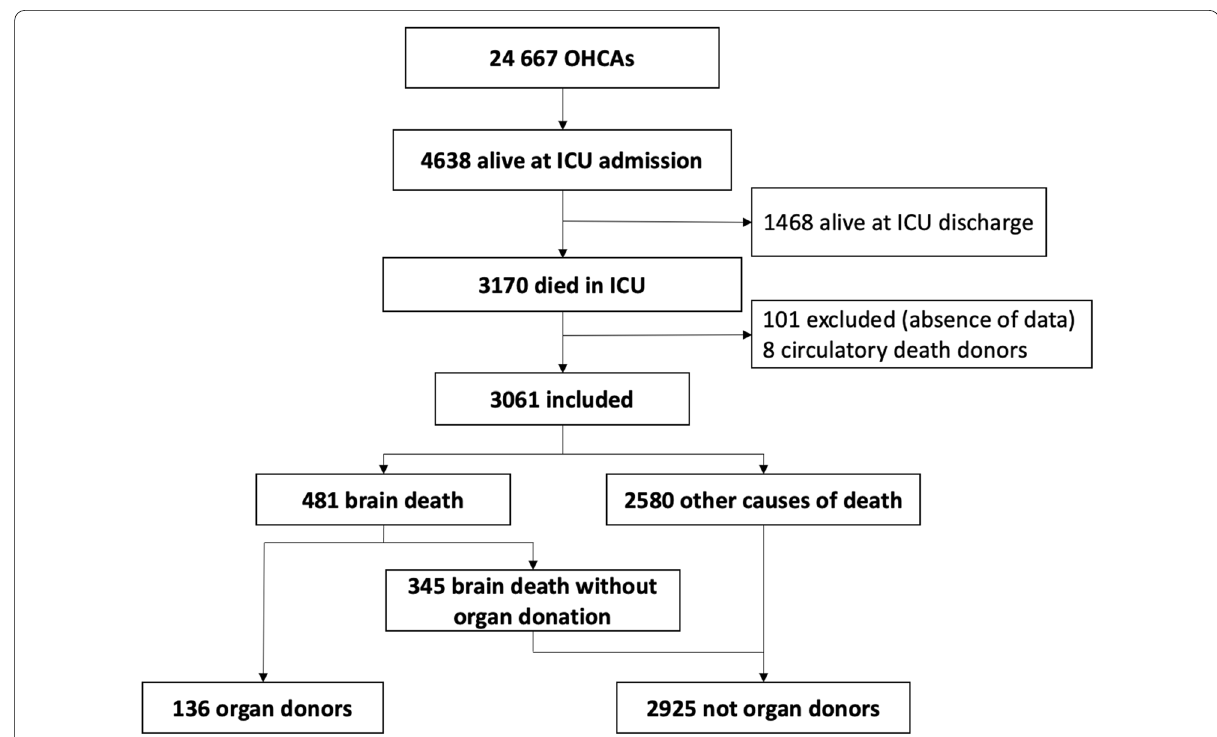
Fig. 1 Patient flowchart. ICU: intensive care unit; OHCA: out-of-hospital cardiac arrest